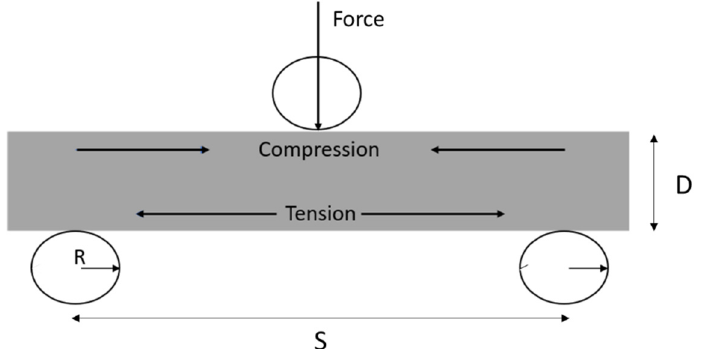
Figure 2. Schematic of three-point bending setup with radius (R) = 5 mm and Span of the grippers (S) = 40 mm to satisfy the ASTM span to thickness ratio of 1:20 and the depth of the sample (D) = 2 mm.